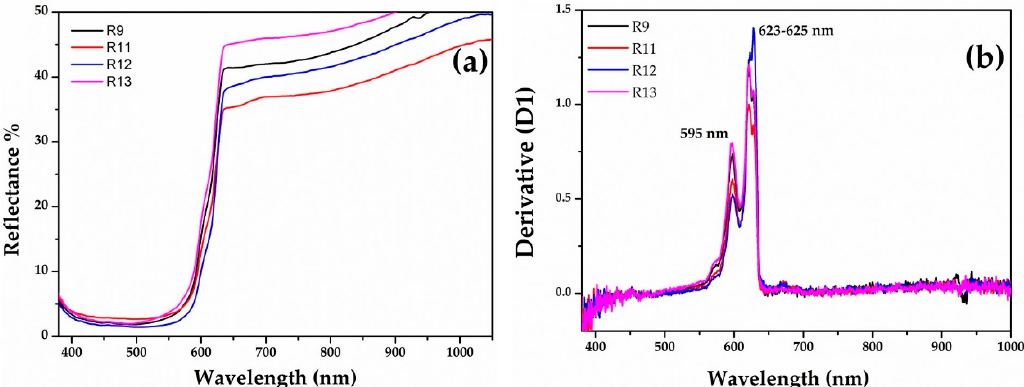
Figure 8. FORS spectra of Gr-4 samples: ( a ) reflectance spectra of Gr-4 samples in which cuprous oxide could be present as a colouring agent ( b ) with their respective first derivative.